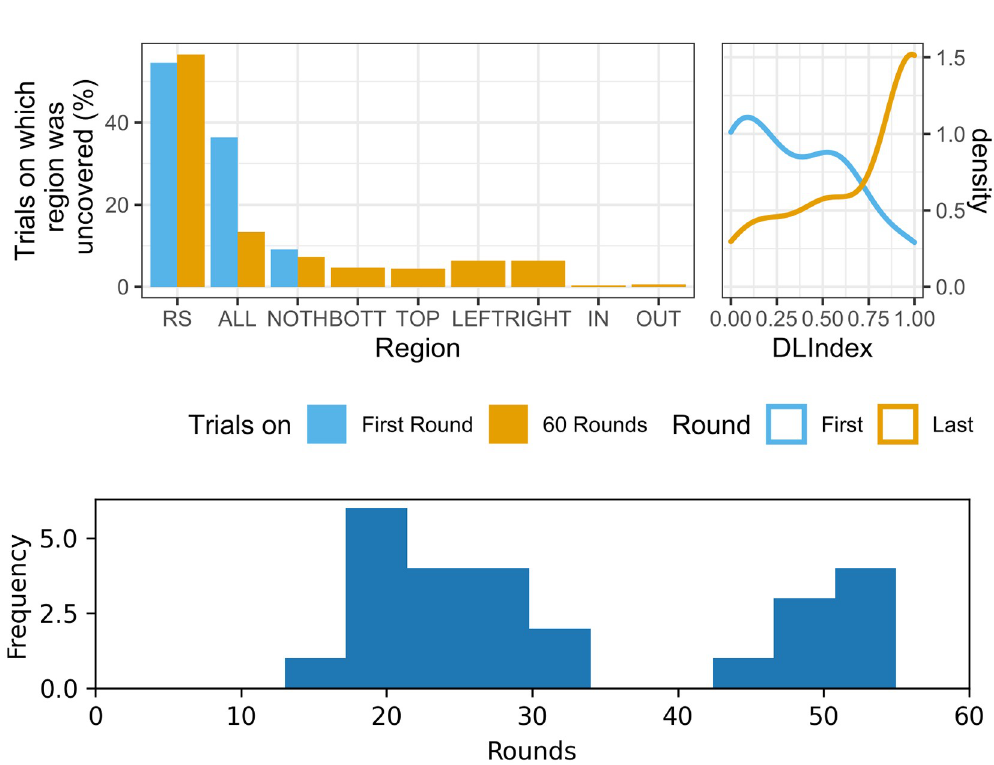
Fig 4. Convergence on a successful division of labor. Top left panel: percentage of trials on which each type of region was uncovered (first round N = 22; all rounds N = 1244). Top right panel: kernel density estimate of DL INDEX (first round N = 22; last round N = 30). Bottom panel: histogram of first round on which DL INDEX reached a stable high value (by considering the first round on which the rolling mean (window = 2) of the DL INDEX was above 0.995). Only successful dyads were considered ( N =